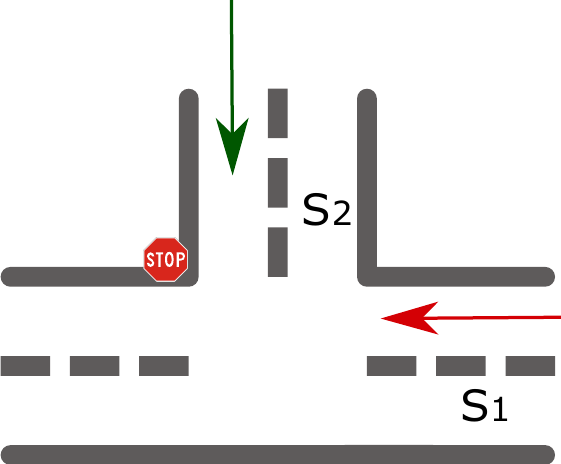
Figure 1. T-intersection with the stop